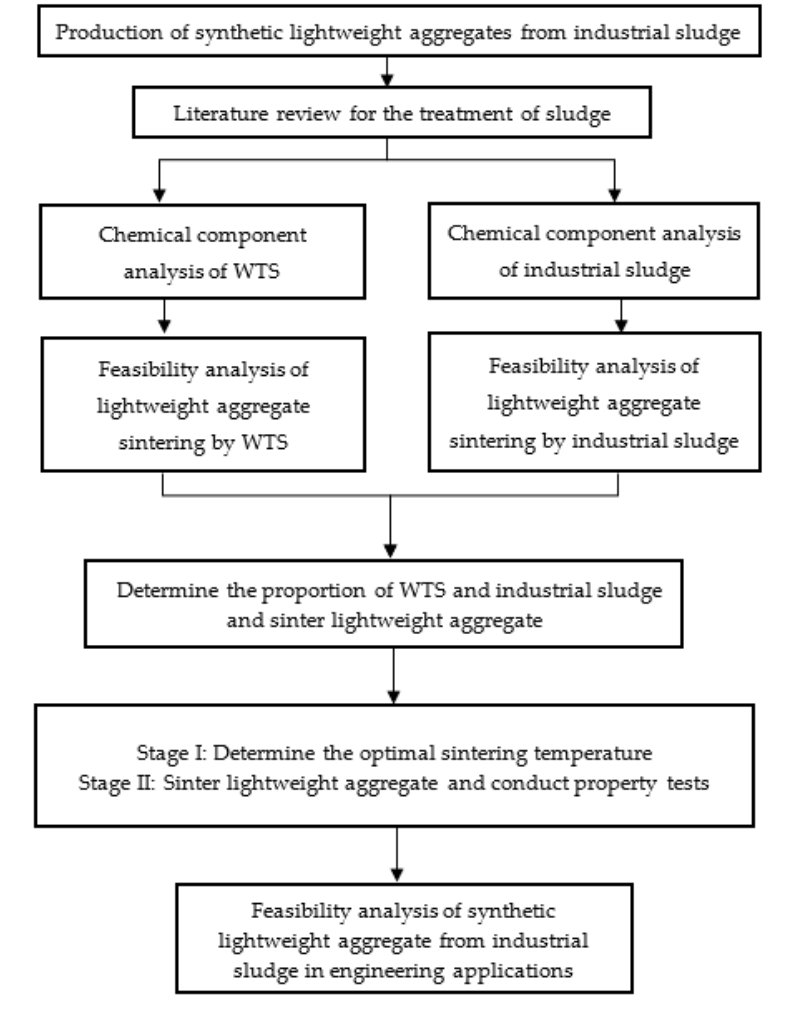
Figure 1. Experimental design and research flowchart.